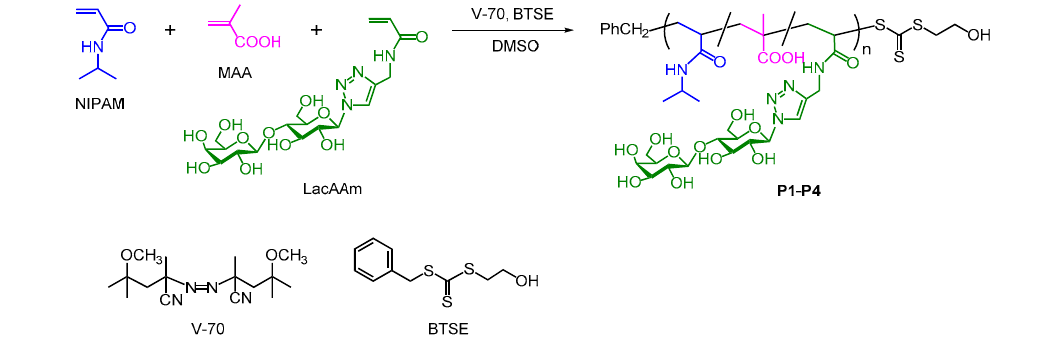
Table 1. Synthesis of glycopolymers.